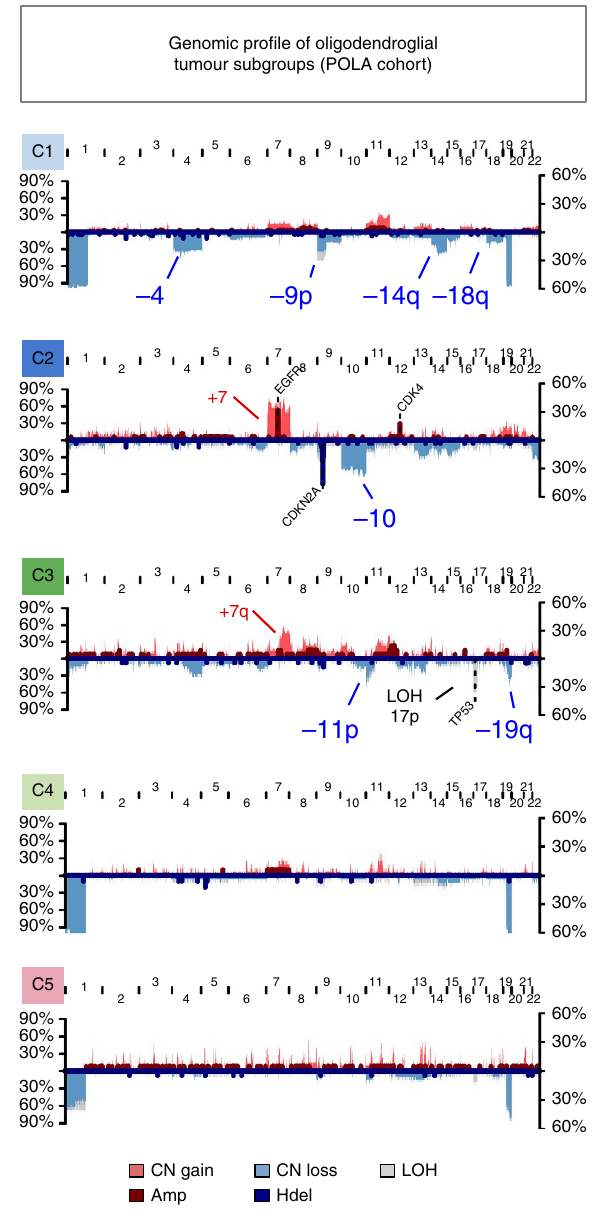
Figure 2 | Genomic profile of oligodendroglial tumour subgroups. We analysed SNP data from 131 of the 141 oligodendroglial tumours characterized. Frequency of genomic amplifications (Amp), copy number gains (CN Gain), copy number losses (CN loss), homozygous deletions (Hdel) and copy neutral LOH events (LOH) are displayed for each of the five subtypes. Left axes show frequencies of CN gains, CN losses and LOH events. Right axes show frequencies of amplifications and homozygous deletions. The most frequently altered chromosome arms are highlightened in red (gain), blue (loss) or black (copy neutral enrichment in gene sets related to the MYC pathway was also observed in TCGA O1 tumours.